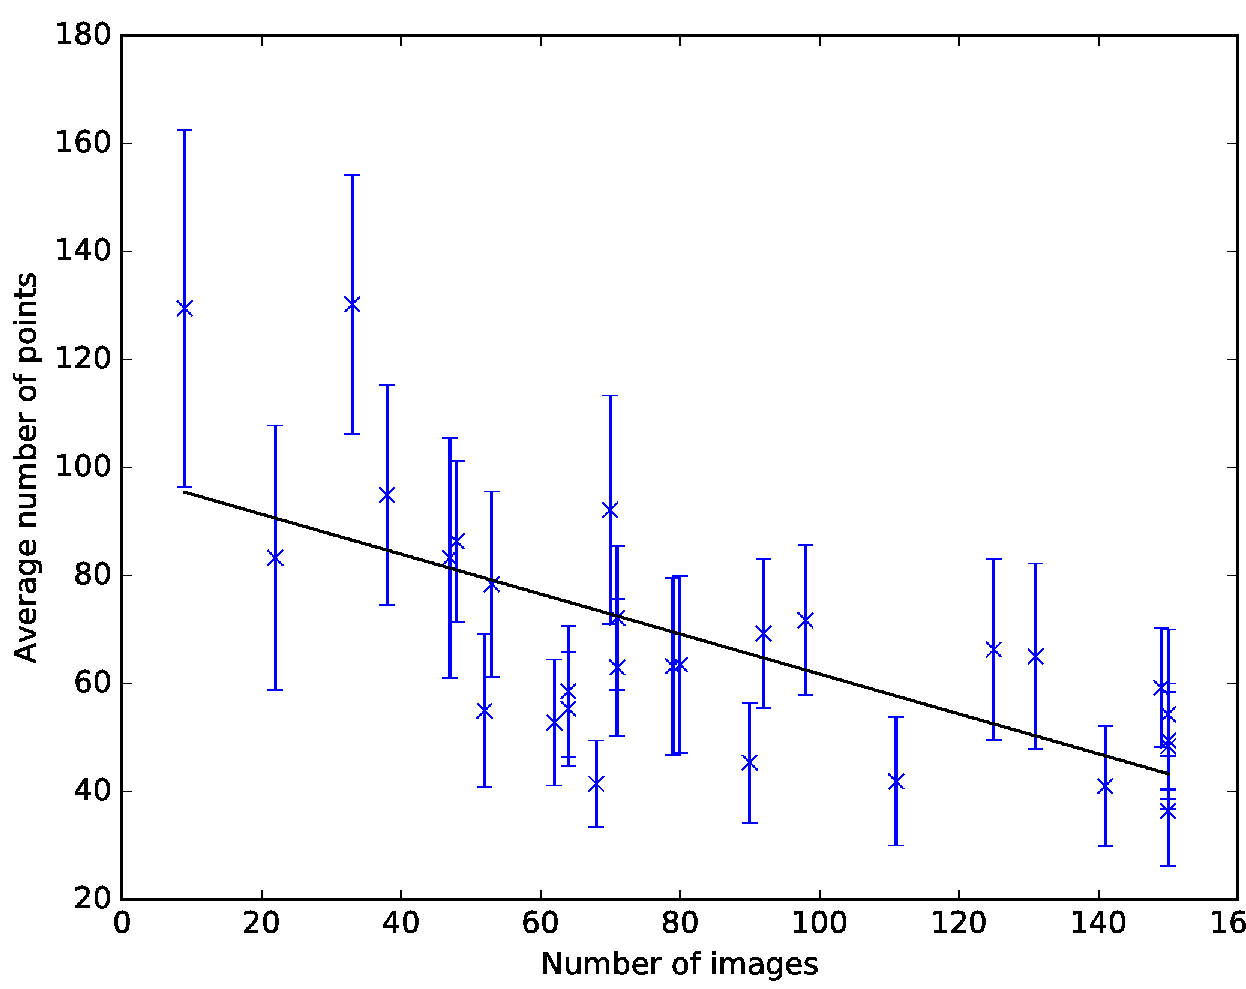
Fig 3. Number of points versus number of images analysed. Error bars show the standard deviation.